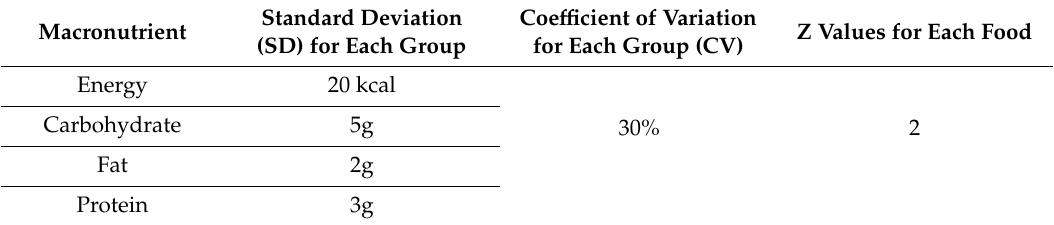
Table 2. Criteria proposed for the definition of the sports foods exchanges in each group. Definitive values of macronutrients and energy assigned to each food sport exchange